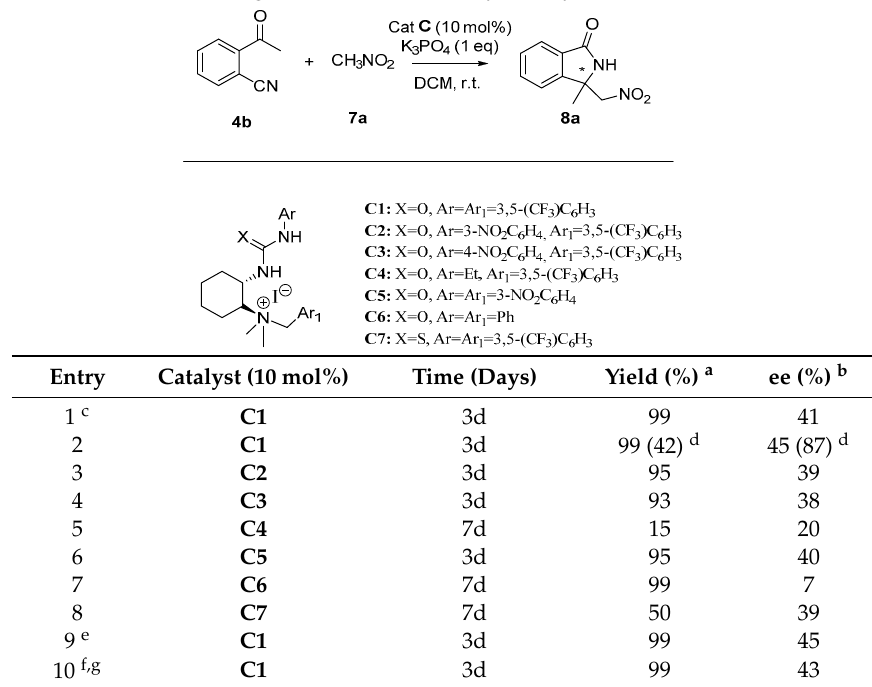
Table 3. Screening of different trans -1,2-cyclohexyldiamine based PTC.